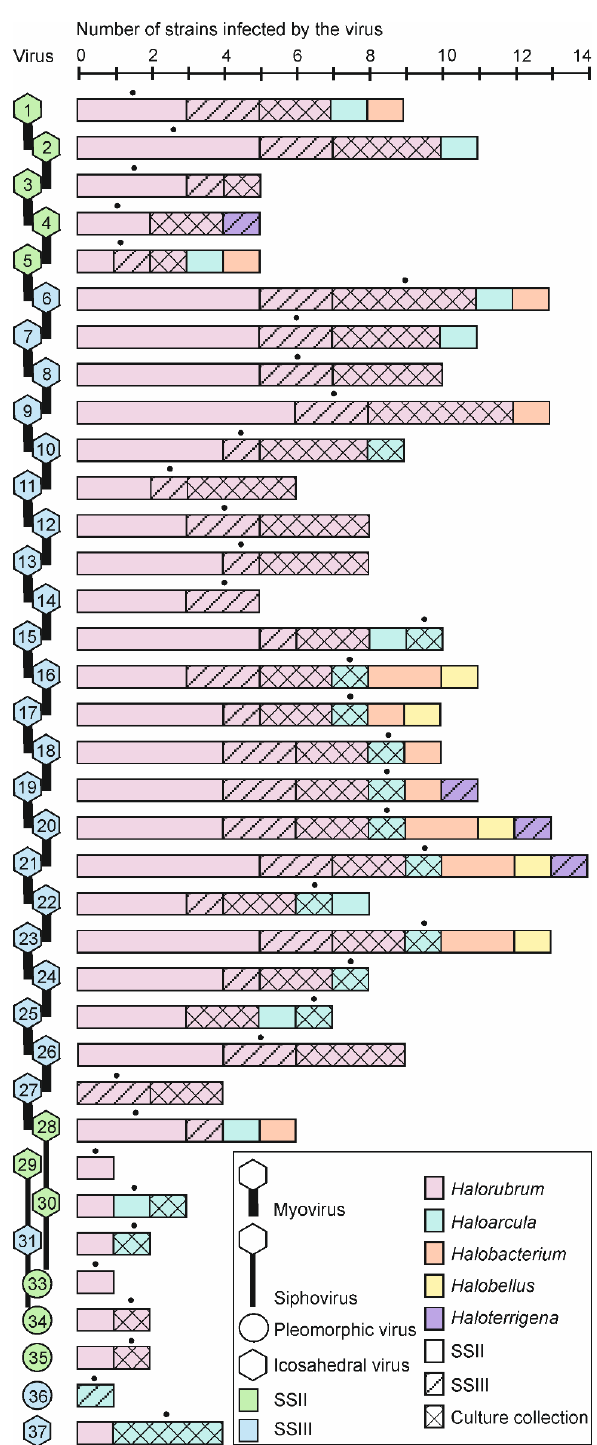
Figure 3. Host range of viruses. Genus distribution of the virus host strains is indicated by a colored column corresponding to the number of infected strains (Supplementary Tables S3 and S4). Black dot on top of the column indicates the genus of the original isolation host of the virus. The color, pattern, and morphotype codes are presented at the bottom of the figure. See Table 2 for virus